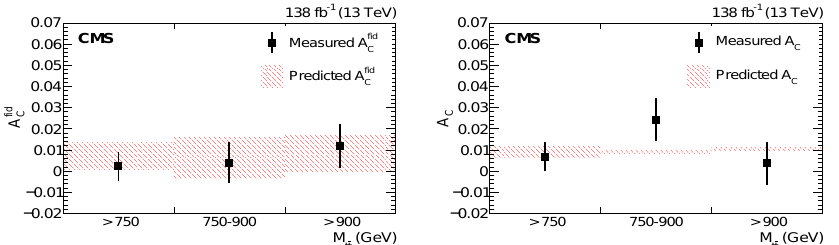
Figure 25. Measured A t ¯ t in the fiducial phase space ( left ) and in the full phase space ( right ) presented C in different mass regions after combining the µ +jets and e +jets channels [64]. The vertical bars represent the total uncertainties, with the inner tick mark indicating the statistical uncertainty in the observed data. The measured values are compared to the theoretical prediction, including NNLO QCD and NLO EW corrections, calculated with the methods described in Ref. [15]. The theoretical prediction in the fiducial region is obtained by fitting Asimov data that passed the signal candidate